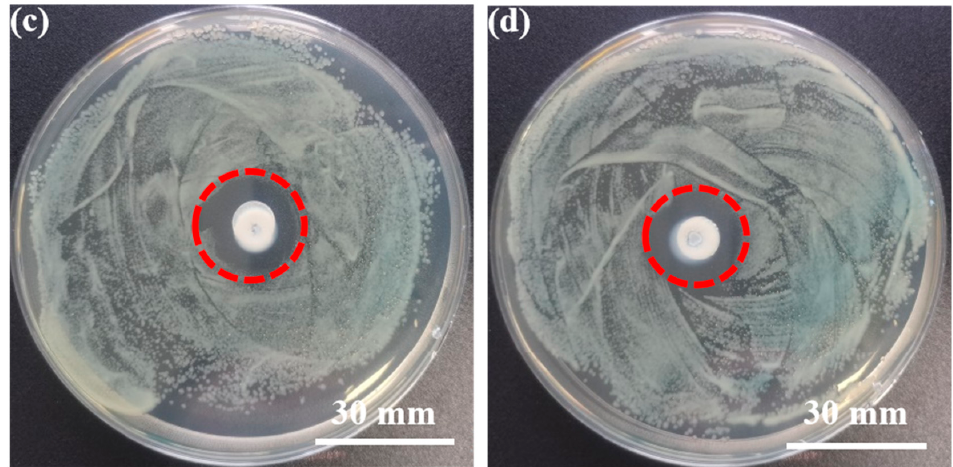
Figure 5. Anti-bacterial effect of ( a , c ) Zn-1Cu-0.5A g and ( b , d ) Zn–1Cu–1Ag after co-culturing with ( a , b ) S. aureus and ( c , d ) E. coli for 24 h. Table 3. Inhibition zone diameter (IZD) values of the Zn-1Cu-xAg alloys against model bacteria. Materials